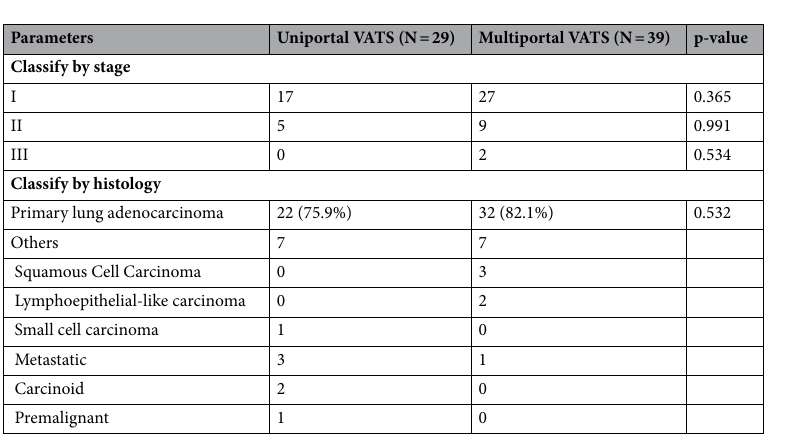
Table 3. Pathology of lung resections after Uniportal VATS versus Multiportal VATS.